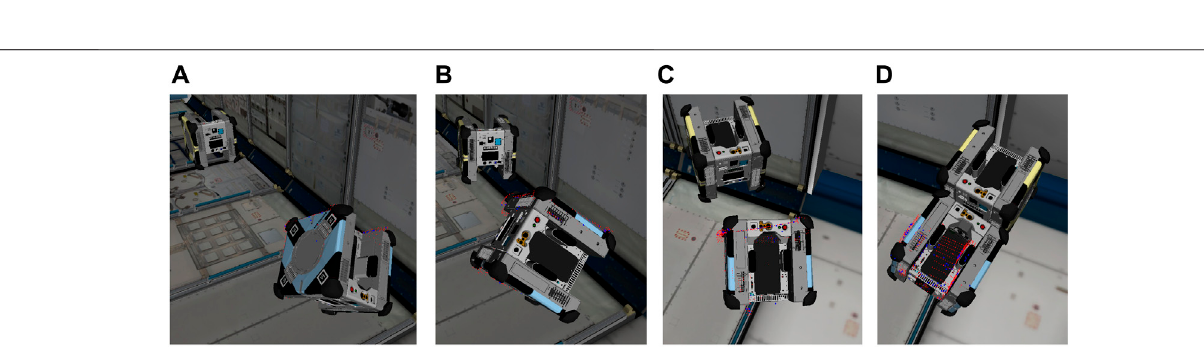
Frontiers in Robotics and AI |